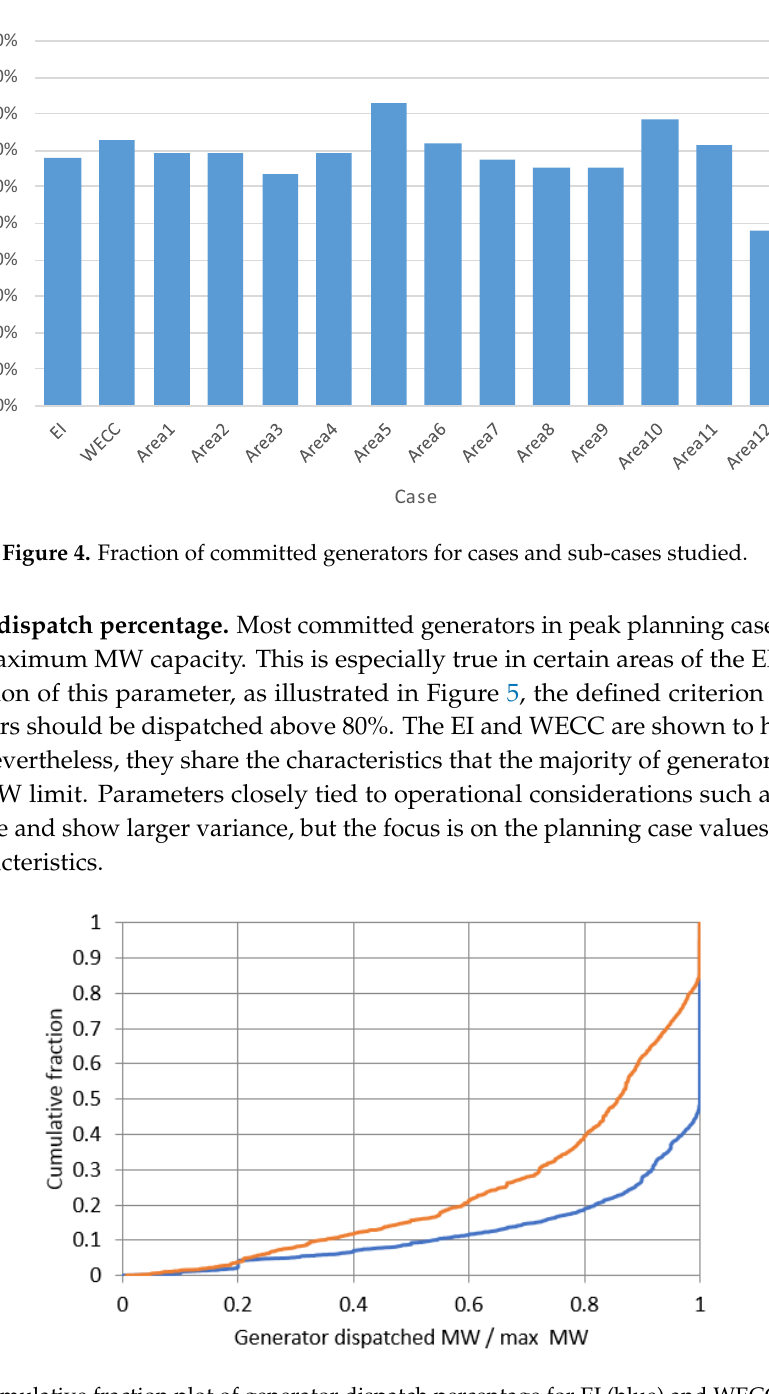
Figure 5. Cumulative fraction plot of generator dispatch percentage for EI (blue) and WECC (orange).